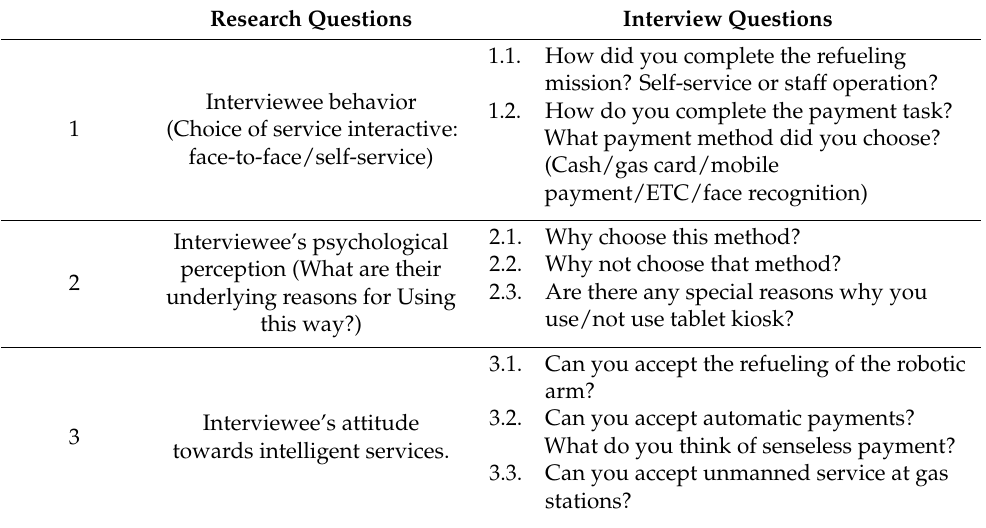
Table 3. The examples of interview questions developed based on research